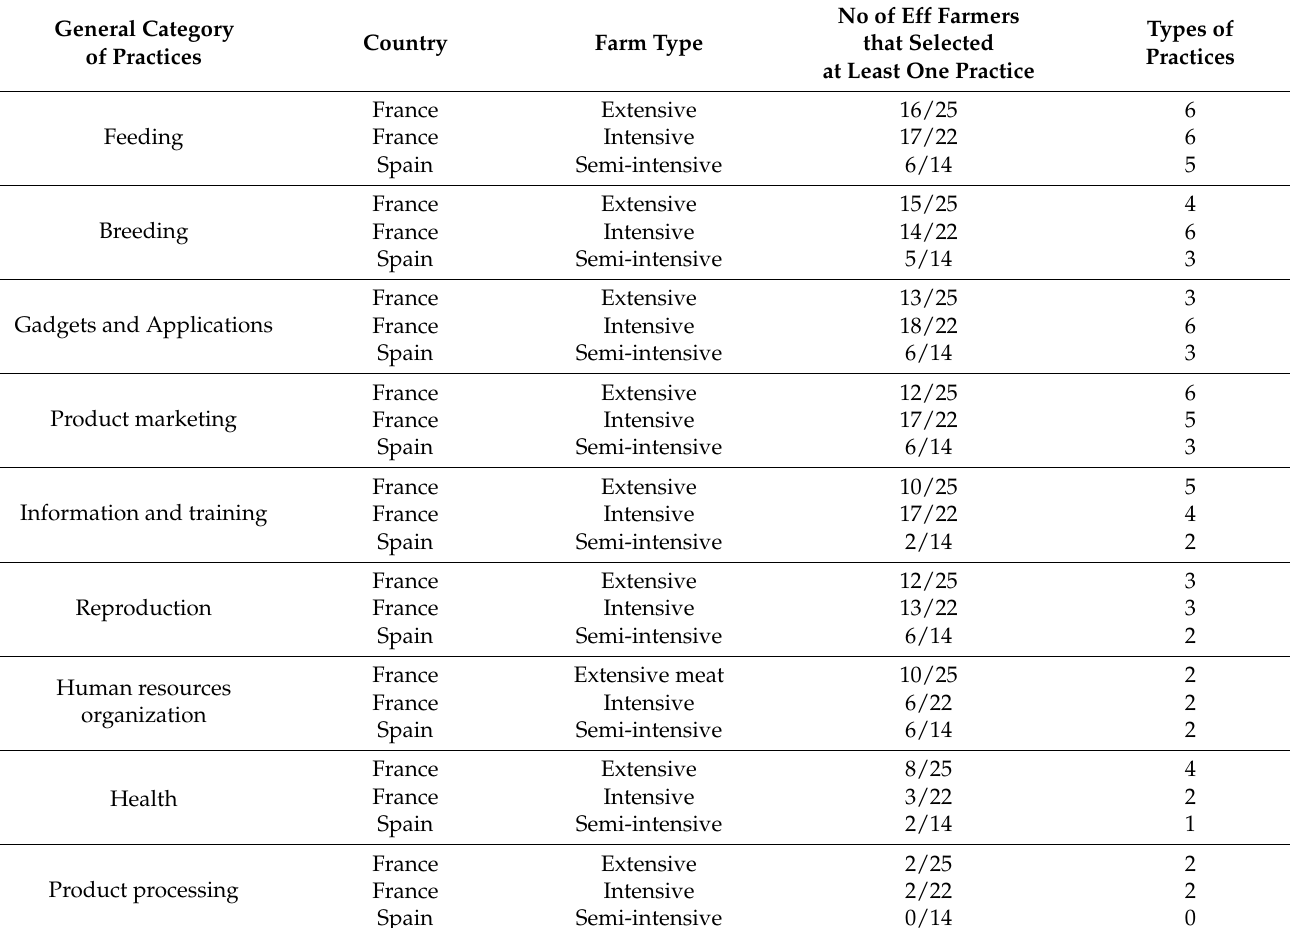
Table 5. General categories of best observed practices and innovations in efficient French and Spanish